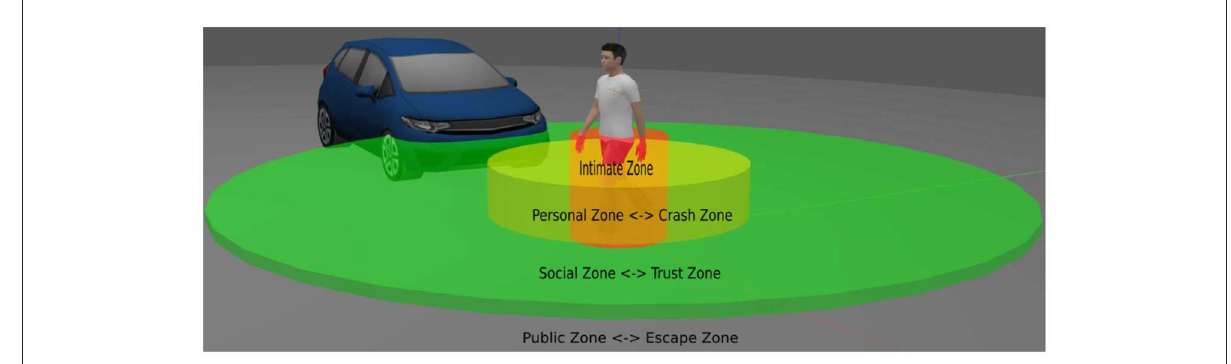
FIGURE11 Autonomous vehicle entering pedestrian’s social zone, which can also be viewed and quantified as a trust region (Camara and Fox, 2020, 2022).